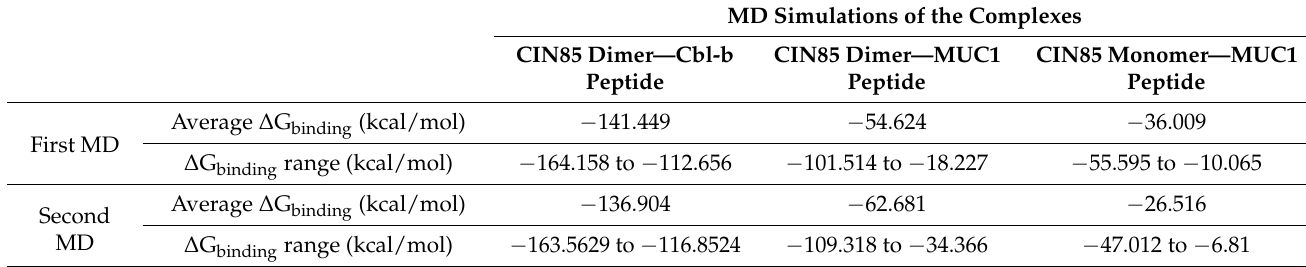
Table 2. ∆ G binding values calculated for each MD simulation. MD Simulations of the